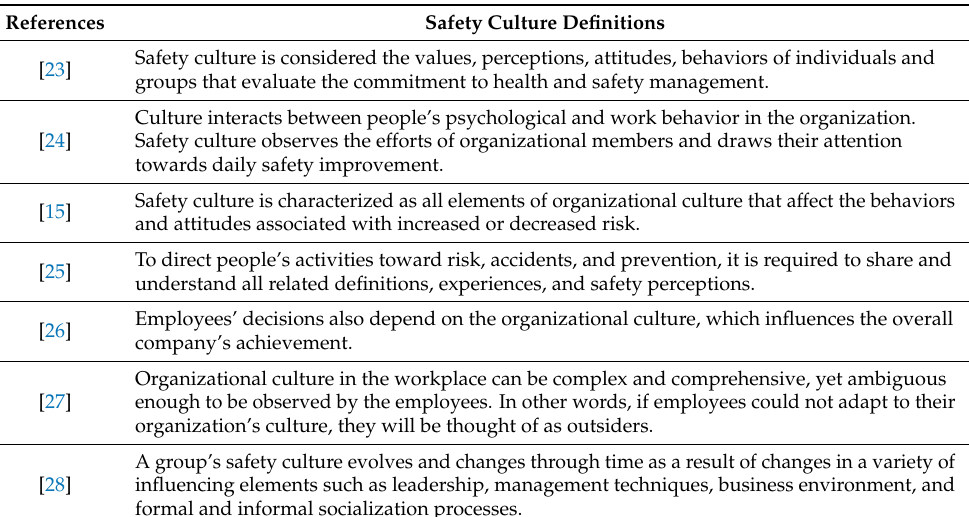
Table 1. Safety culture